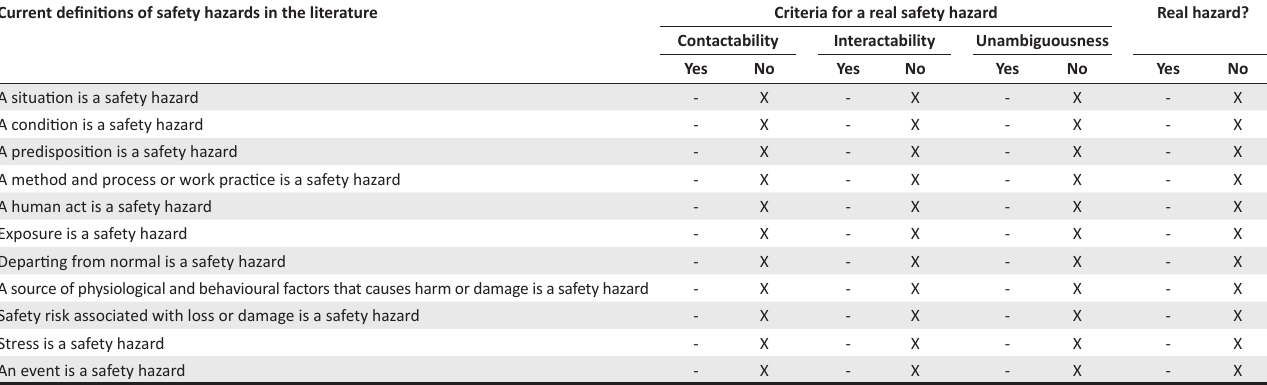
TABLE 1: Contextual assessment of definitions of a safety hazard. Current definitions of safety hazards in the